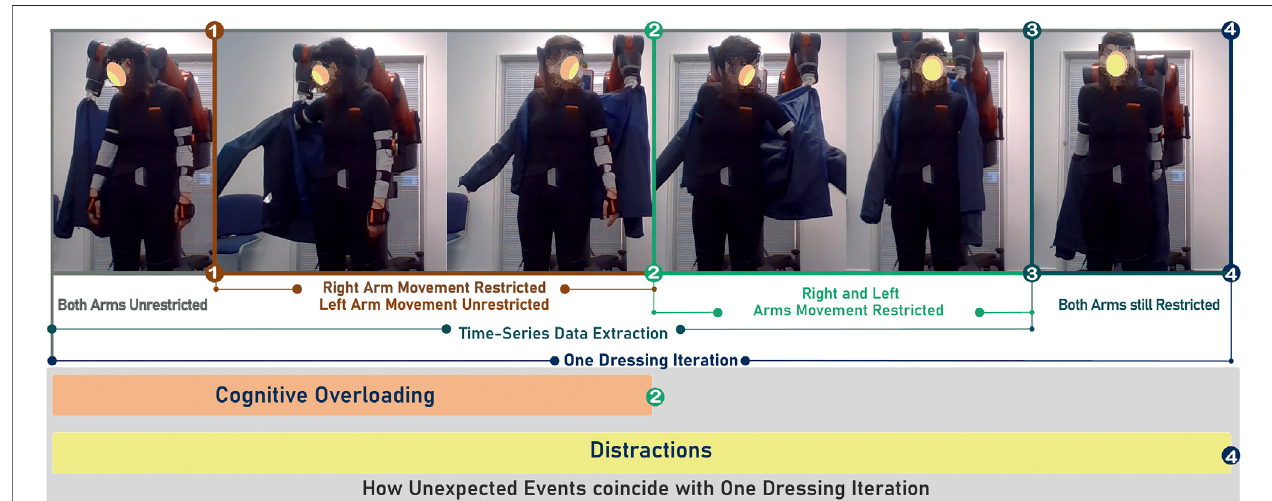
FIGURE 1 | One dressing task timeline. Markers from (1) to (4) highlight the different stages during the assistive task. The fi rst image on the far LHS shows the moment in the dressing task when the right arm is unrestricted. The following two images show the dressing with the left arm unrestricted. The two images between Markers (2) and (3) show the instance where the left hand becomes restricted, followed by an image where both hands become restricted. After Markers (3), the robot drags the jacket back down the arms of the participant. The orange block represents the time during which cognitive overloading occurred. The yellow block represents the time during which distractions occurred. For all three parts of the experiment the dressing task was repeated ten times.